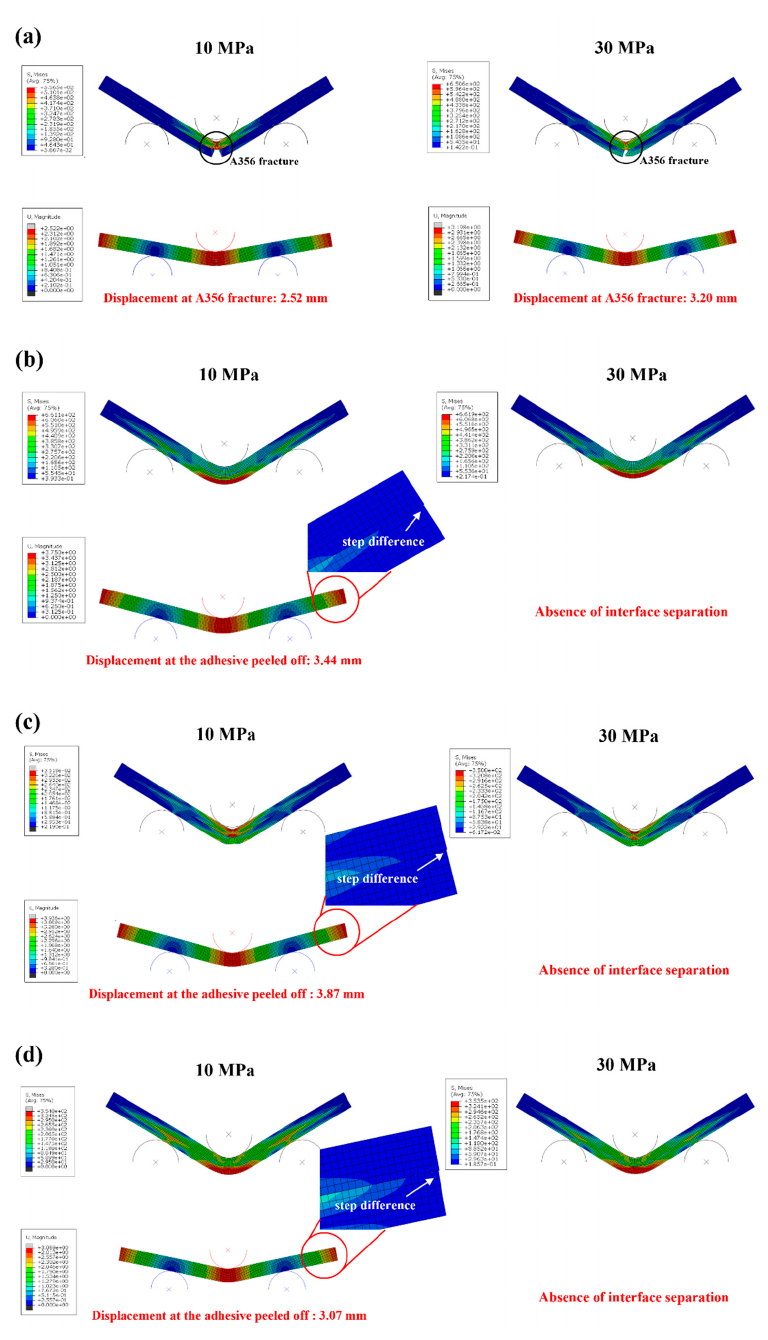
Figure 13. FEA results: ( a ) DP590 (upper)–A356 (lower), ( b ) DP590 (lower)–A356 (upper), ( c ) SS330 (upper)–A5052 (lower), and ( d ) SS330 (lower)–A5052 (upper).